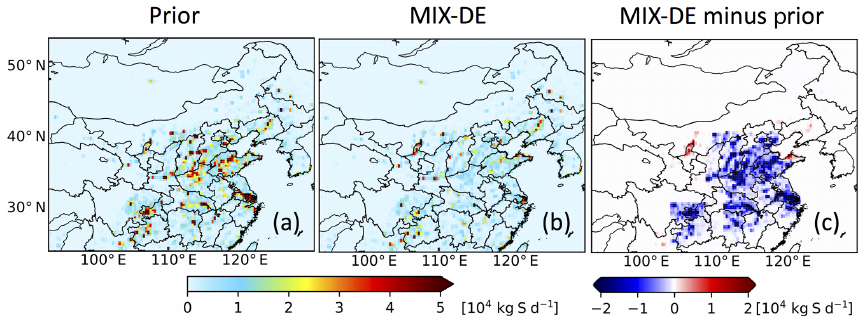
Figure 7. Panel (a) shows SO 2 0 . 25 ◦ × 0 . 3125 ◦ emissions of prior MIX 2010, (b) shows posterior MIX-DE, and (c) shows the difference between posterior MIX-DE and prior MIX 2010.